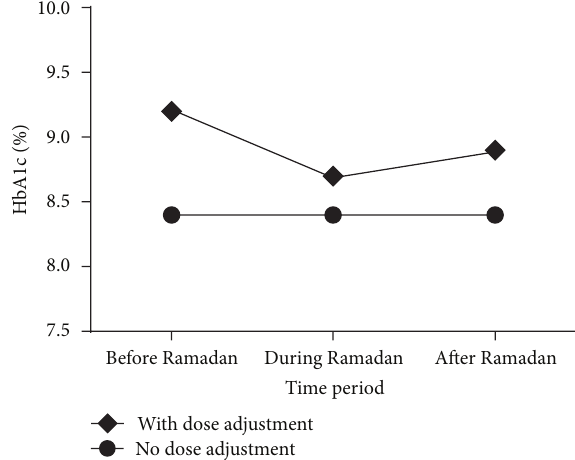
Figure2:TrendsofchangeinmeanHbA1cinrelationtoadjustment of the dose of antidiabetic